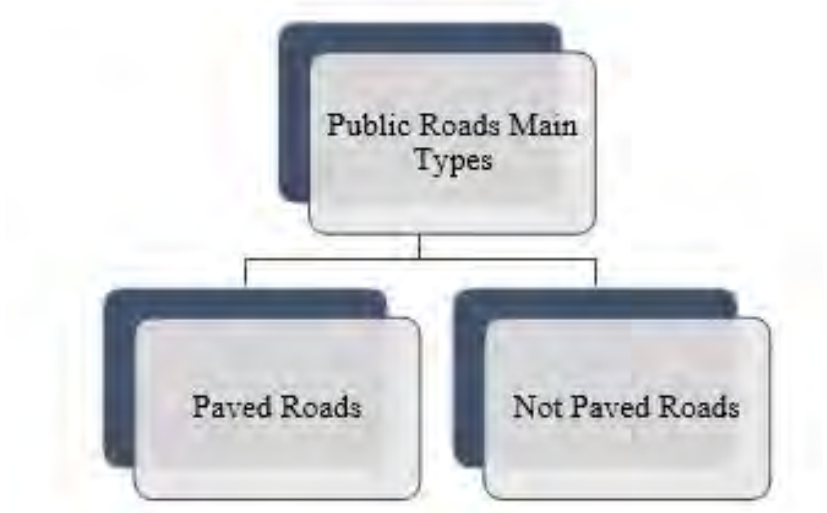
Figure 8. The Public Roads’ Main two types (the researcher,